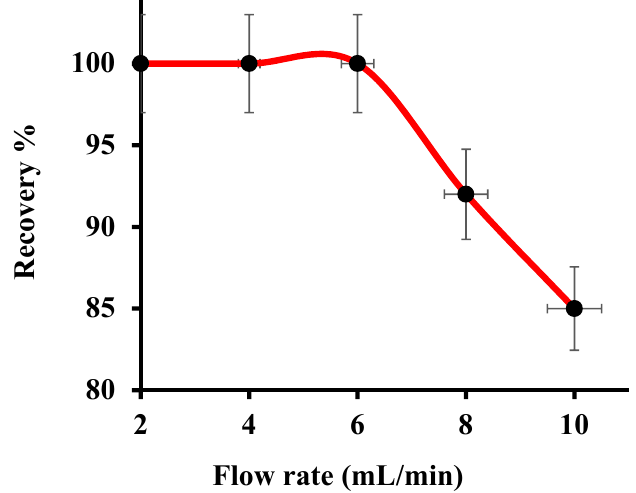
Figure 4. E ff ect of the column flow rate (experimental conditions: sample pH of 7; eluent = 5 mL of 0.5 M of HCl; mass of adsorbent = 50.0 mg; Hg 2 + = 250 µ g mL − 1 ; T = 27 ◦ Figure 4. Effect of the column flow rate (experimental conditions: sample pH of 7; eluent =5 mL of 0.5 M of HCl; mass of adsorbent = 50.0 mg; Hg 2+ = 250 µg mL − 1 ; T = 27 °C).